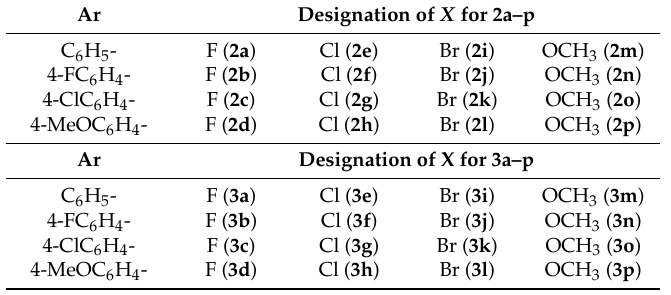
Table 1. Substitution pattern for compounds 2a – p and 3a – p .